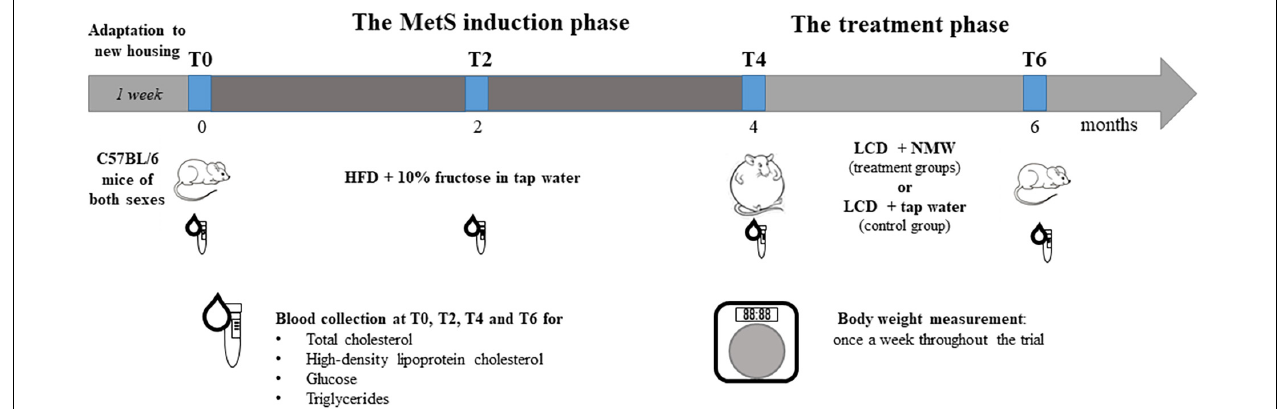
FIGURE 1 | Experimental design. Both male and female C57BL/6 mice were initially fed a high-calorie diet (HCD) with 10% fructose in tap water over a period of 4 months to induce MetS (the MetS induction phase). Mice were then randomly divided into treatment groups and a control group, all of which received a low-calorie diet (LCD), but with a different kind of drinking water, for 2 months (the treatment phase). The treatment groups were each treated with a different kind of NMW, and one group – the control group – was given tap water. Body weight and blood biochemistry were monitored over the 6-month trial: before (T0) and after 1 (T1), 2 (T2), 3 (T3), and 4 (T4) months feeding on HCD, and after 2 months (T6) on LCD. TABLE 1 | Characteristics of the kinds of drinking water used in the study.